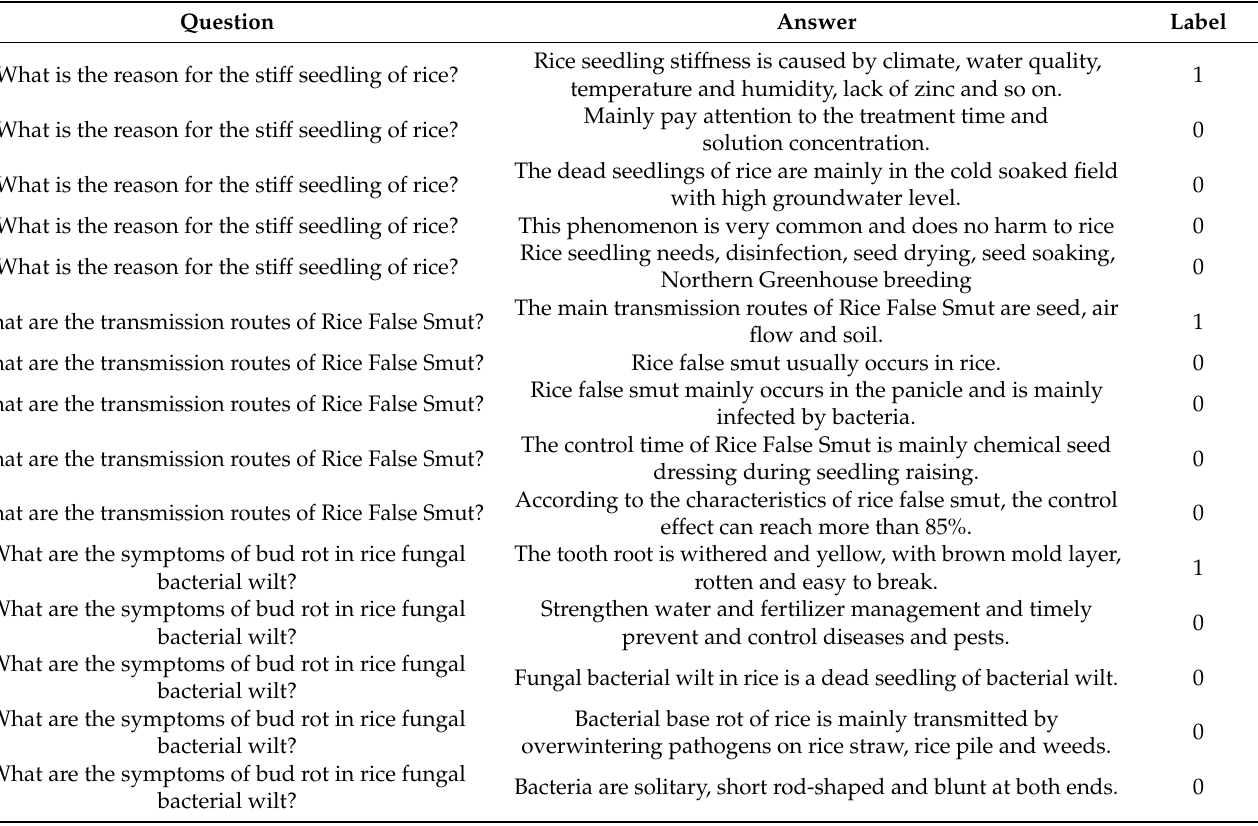
Table 1. Sample of rice-related answer selection